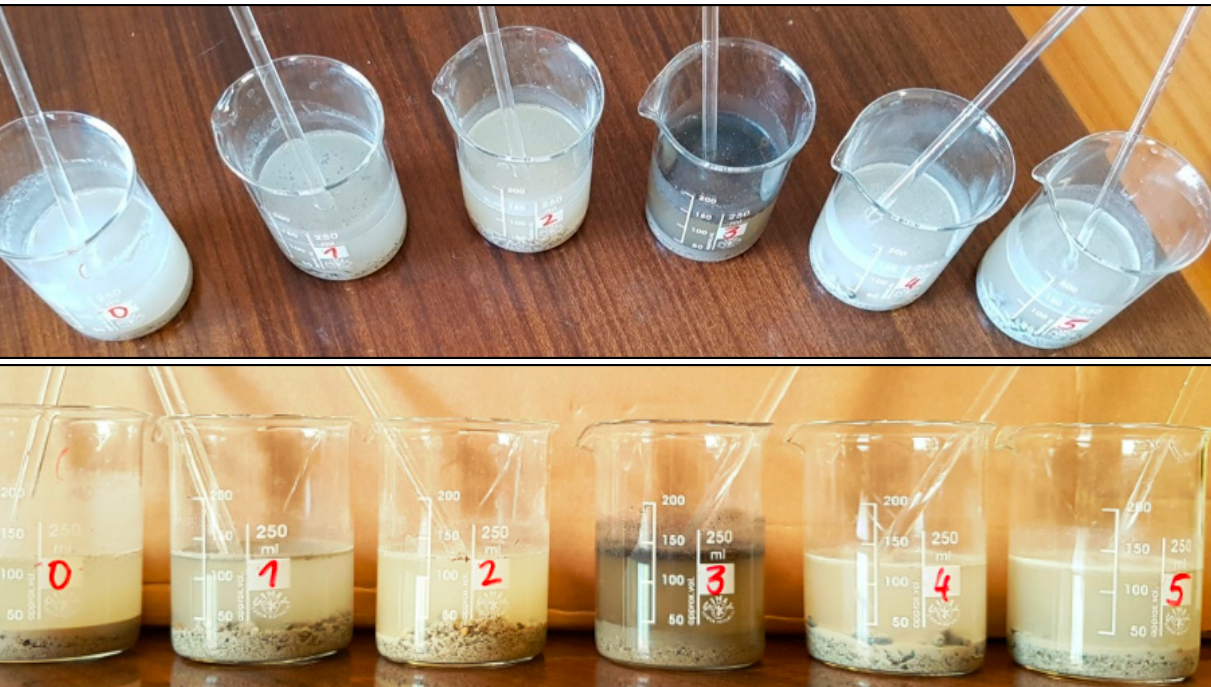
Figure 10. Suspensions made from deionized water and crushed concrete from the bridge.